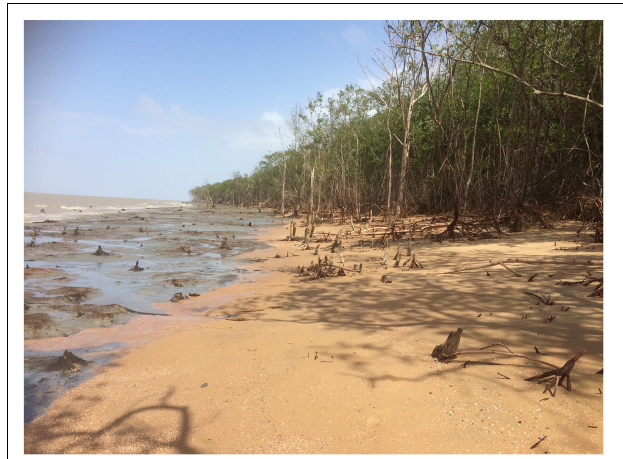
FIGURE 7 | Narrow and fragmented chenier fronting retreating mangrove-colonized mud (February, 2016) in the trailing edge of the inter-bank area. Local reworking and concentration of the sand can lead to the appearance of a coherent chenier visible on satellite images. These narrow fragmented cheniers can migrate landward as coherent sand bodies, asphyxiating seafront